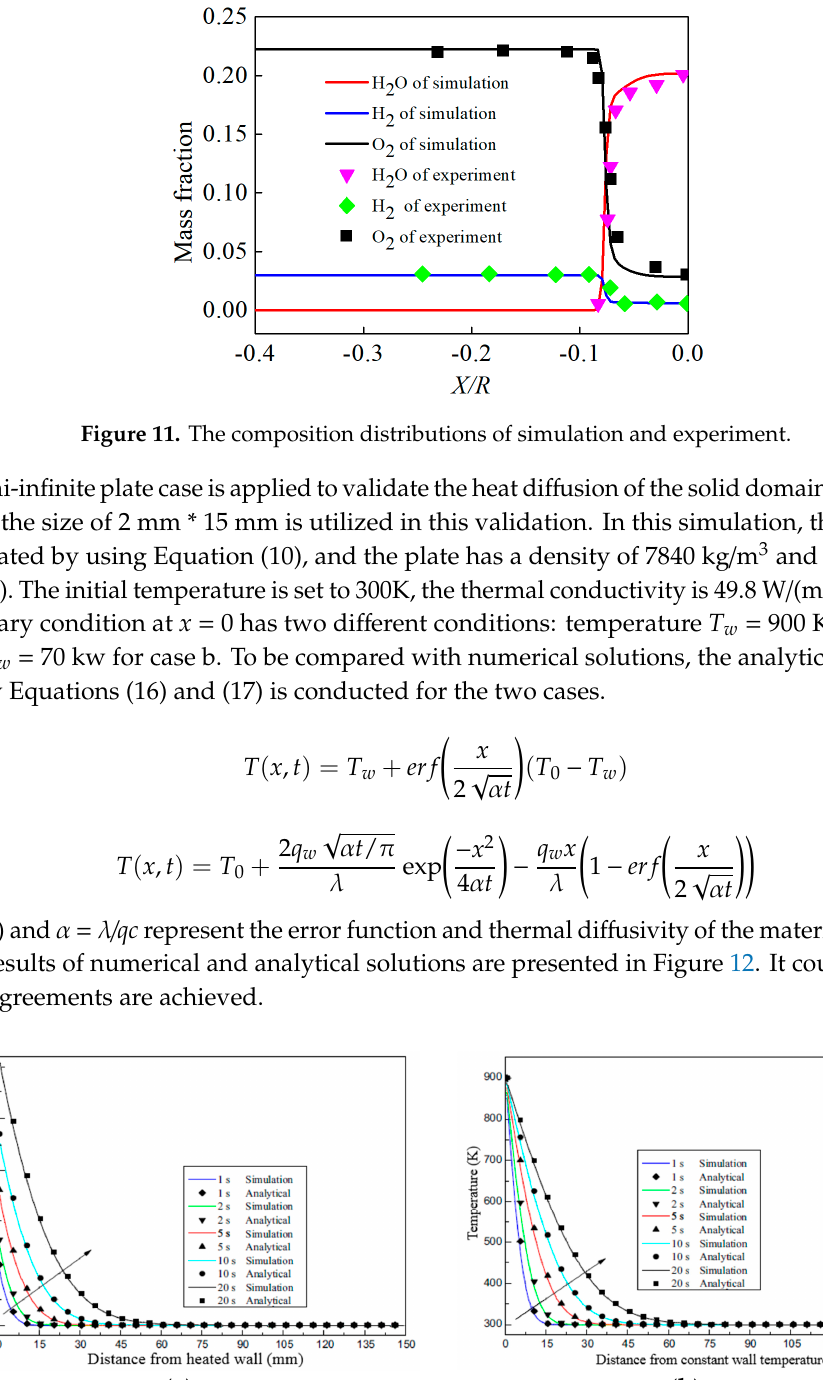
Figure 12. Temperature profiles case ( a ) T w = 900 K and case ( b ) heat flux q w = 70 kw